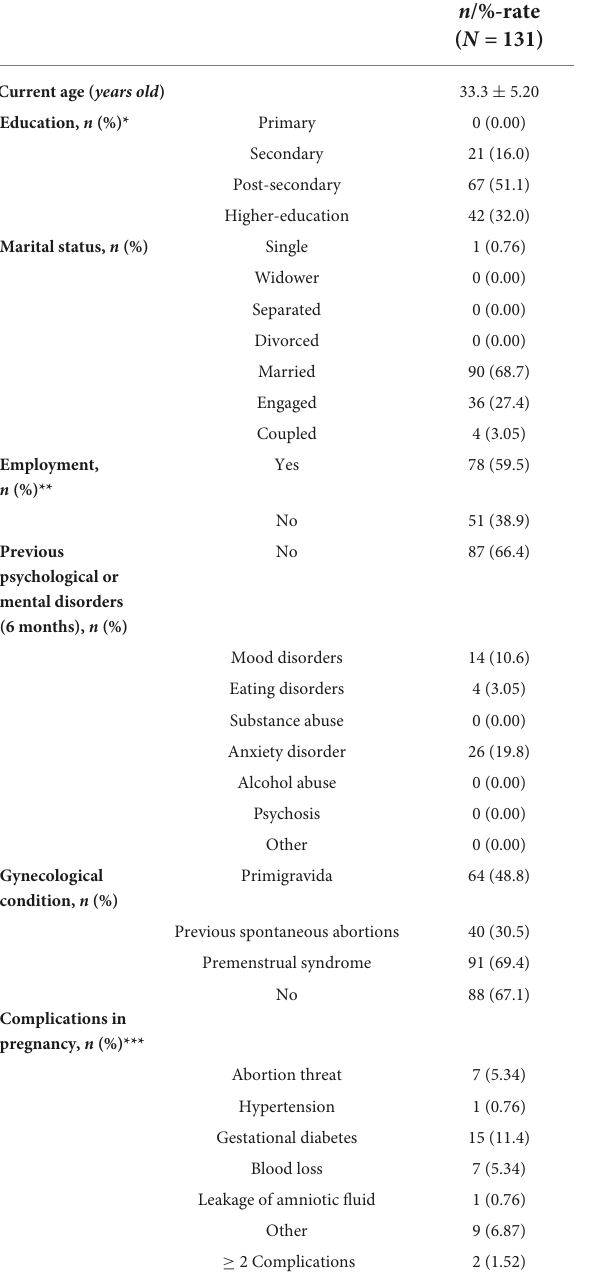
TABLE 4 Socio- demographic and clinical characteristics at intake for women reporting EDPS total score ≥ 12 (T1; N = 131). Characteristics